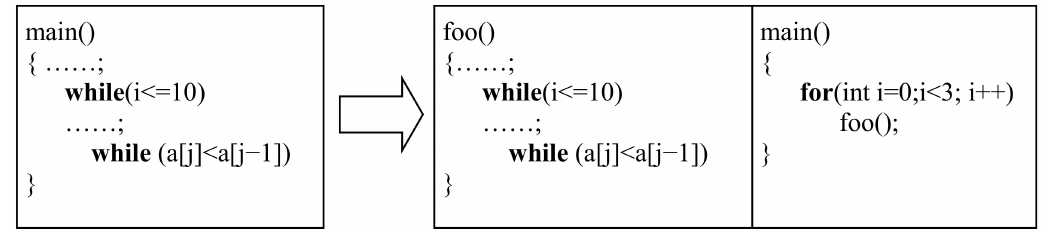
Figure 2. Modification of Example